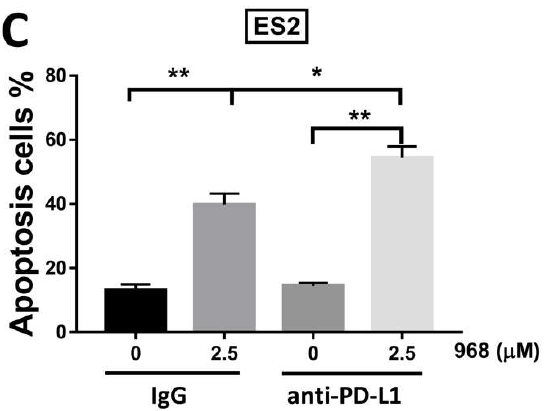
Figure 3. Apoptosis of cancer cells increased in the co–culture system with CD8 + T cells when exposed to compound 968. Flow cytometry was used to examine the apoptosis rate of cancer cells in the direct and indirect co–culture systems. ( A ) In the direct co–culture system, the apoptosis of ES2/A2780CP cells treated with different concentrations of 968 in the presence or absence of CD8 + T cells at a ratio of 1:5. The cancer cells and CD8 + T cells were collected at the end of co–culturing and were stained with FITC–annexin V and PE–anti–CD8 antibody. Annexin V+ cells within the CD8–gate were considered to be apoptotic cancer cells. ( B ) In the indirect co-culture system, apoptosis of ES2/OVCA433 cells seeded in the lower chamber treated with 0 or 5 μM of 968 with or without CD8 + T cells at a ratio of 1:5. ( C ) In the direct co–culture system, the apoptosis of ES2 cells increased when exposed to compound 968 and anti–PD–L1 antibody. The results are presented as the mean ± SD, and data from three experiments are shown (* p < 0.05, ** p < 0.01, *** p < 0.001).